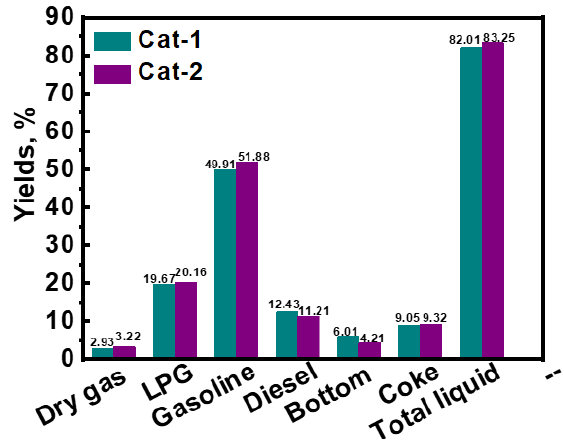
Figure 9. Heavy oil catalytic cracking performances of contaminated FCC catalysts.